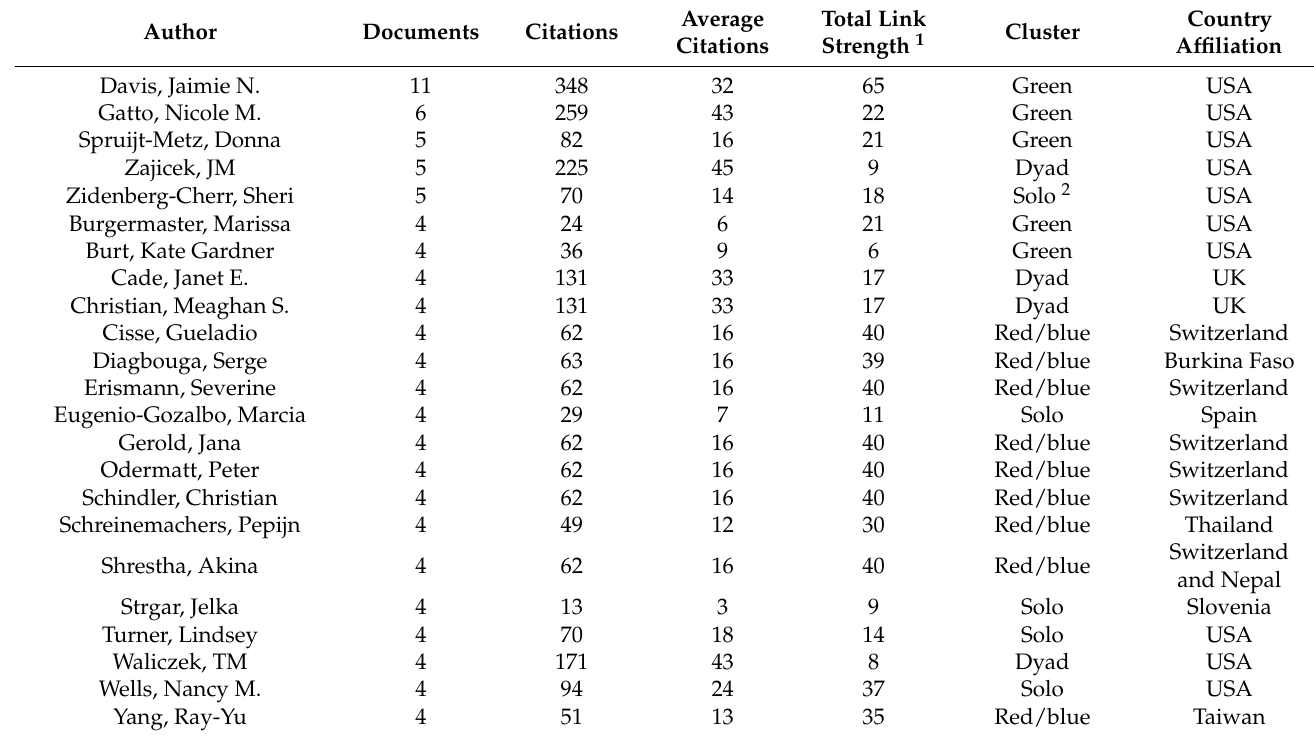
Table 1. Prolific authors (over four publications).